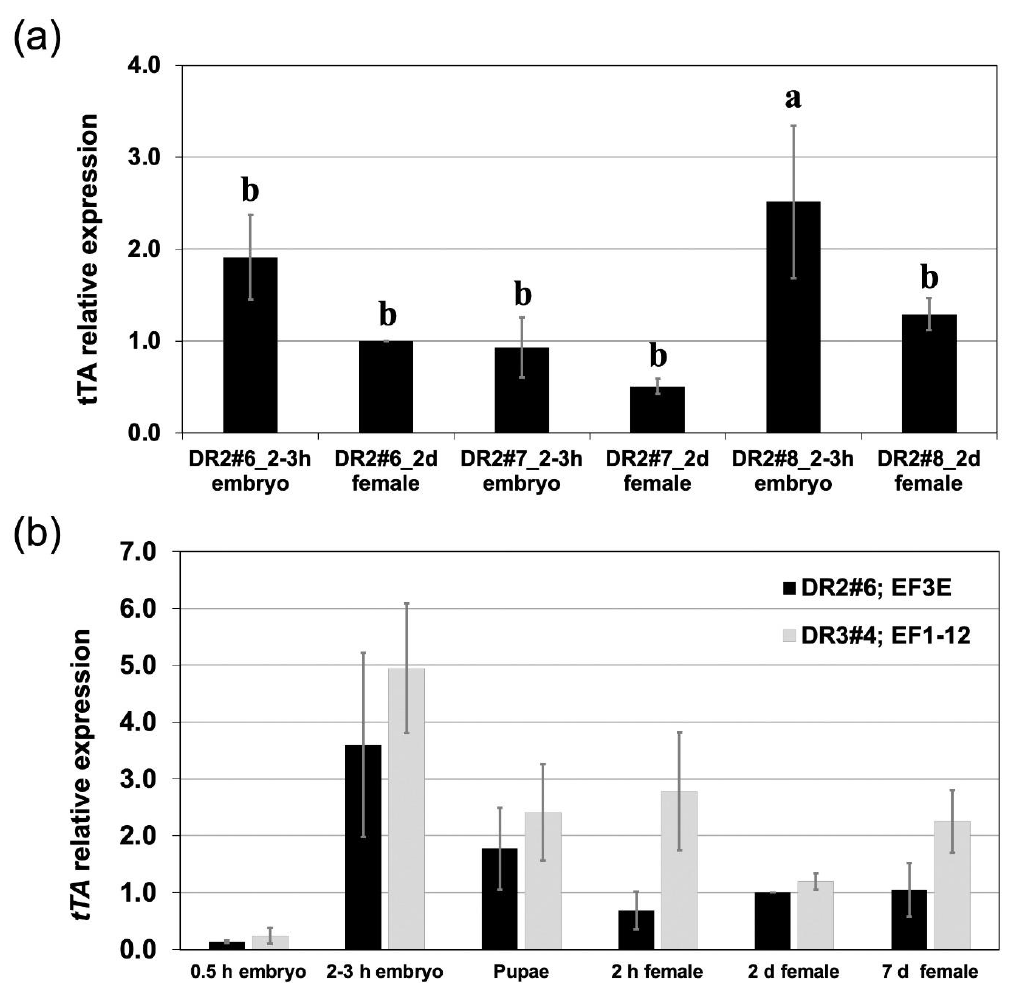
Figure 1. Evaluation of tTA expression from different driver lines by qRT-PCR. ( a ). Relative tTA expression levels in early embryo (2 h or h after egg laying) and young females (2 days or d after eclosion) of three DR2 driver lines were determined. The numbers with different lower-case letters are significantly different ( P < 0.05, One-way ANOVA). ( b ) Relative tTA expression levels at different development stages of DH strains DR2#6; EF3E and DR3#4; EF1-12 are shown. The embryo samples were collected within 0.5 h or 2-3 h after egg laying and the female samples were collected 2 h, 2 d or 7 d after eclosion. For all qRT-PCR analysis, RNA levels are relative to the LcGST1 reference gene and data are from three biological replicates.